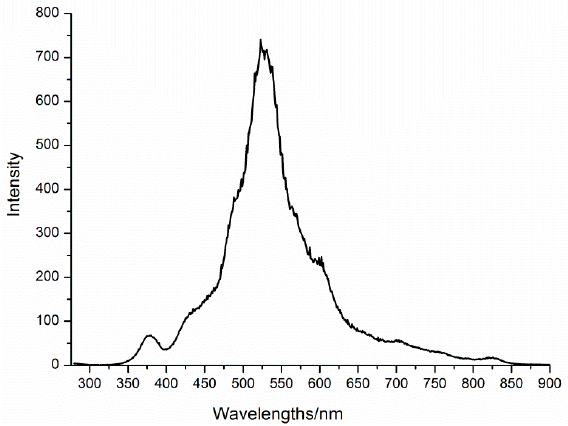
Figure 8. Emission spectrum ( λ ex = 275 nm) of Dy 2 Mn 4 -P 2 W 15 showing Dy III emission.